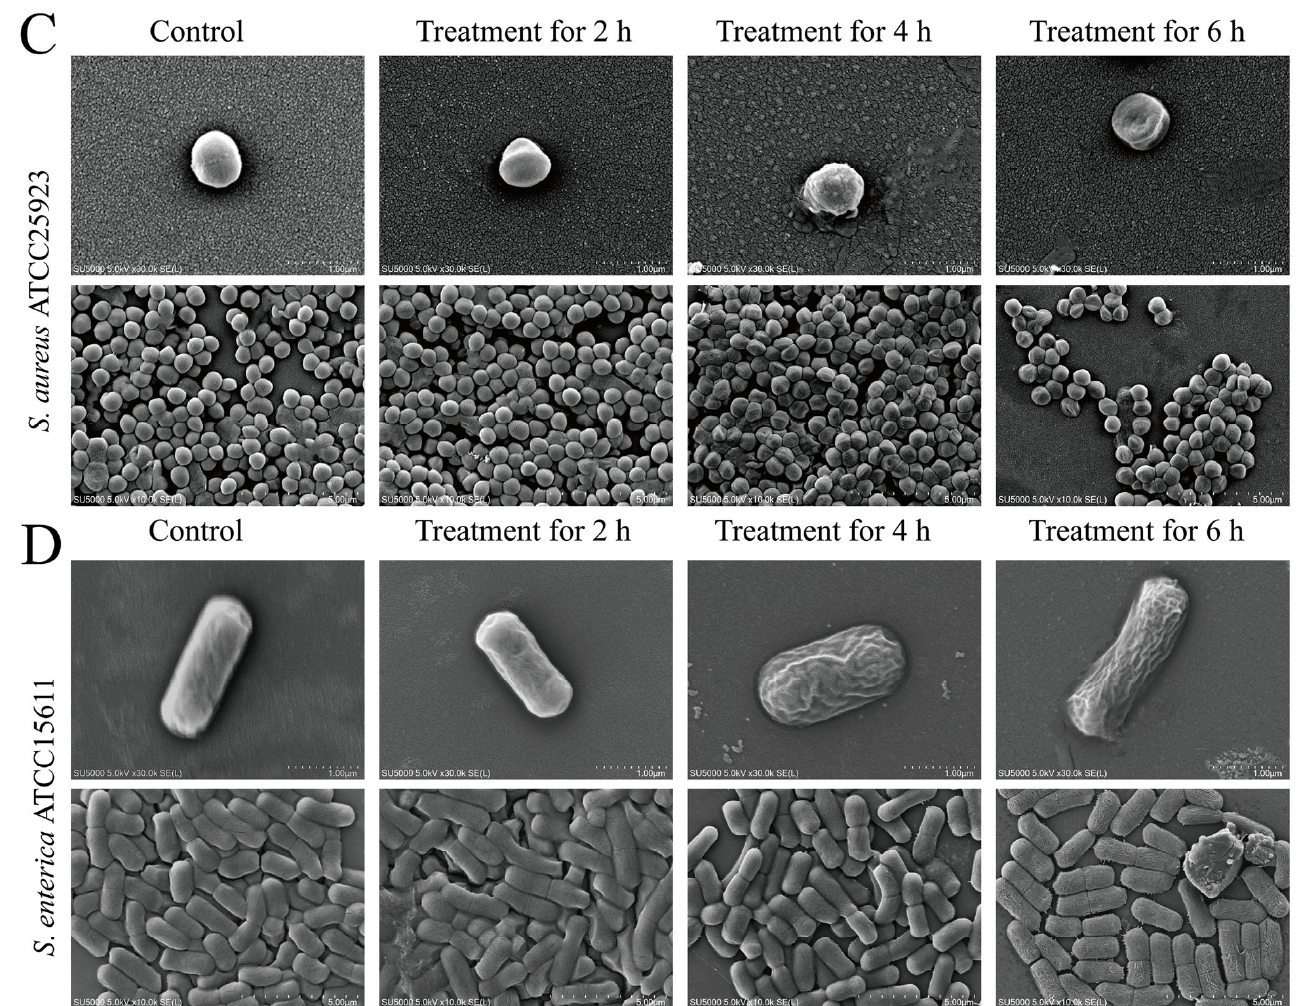
Figure 5. SEM observation of cell surface structure of the four bacterial strains treated with Fragment 1 for different times. ( A – D ) B. cereus A1-1, S. aureus ATCC25923, E. faecalis C1-1, and S. enterica subsp. enterica ( ex Kauffmann and Edwards) Le Minor and Popoff serovar Vellore ATCC15611, respectively. Similarly, for the Gram-positive S. aureus ATCC25923, in the control group, the surface of the bacterial cells was clear, smooth and wrinkle-free with the typical spherical structure. However, after being treated with Fragment 1 for 2 h, although most cells were plump and spherical with complete cell structure, a small number of the cells shrank on the surface. After treatment for 4 h, the surface of most cells showed slight wrinkles, and even collapsed and lost the spherical structure after the treatment for 6